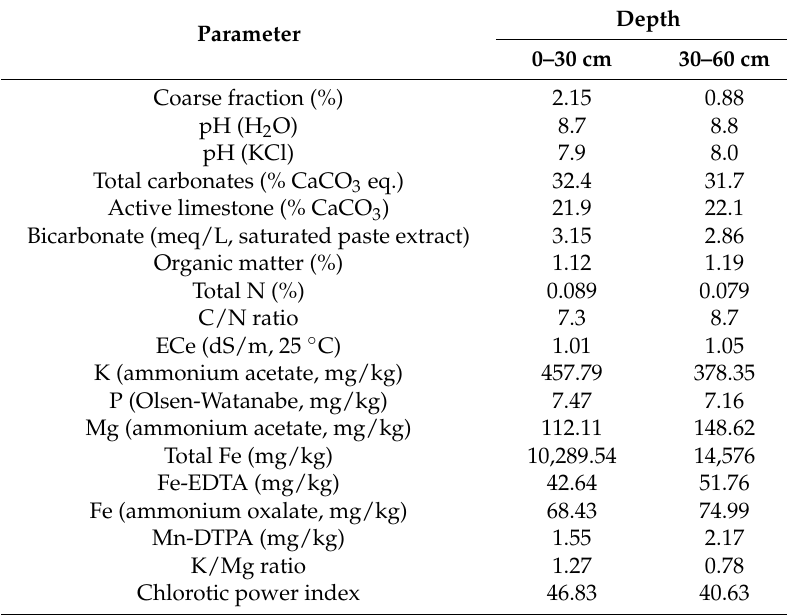
Table 2. Soil analyses results at two depths (0–30 cm and 30–60